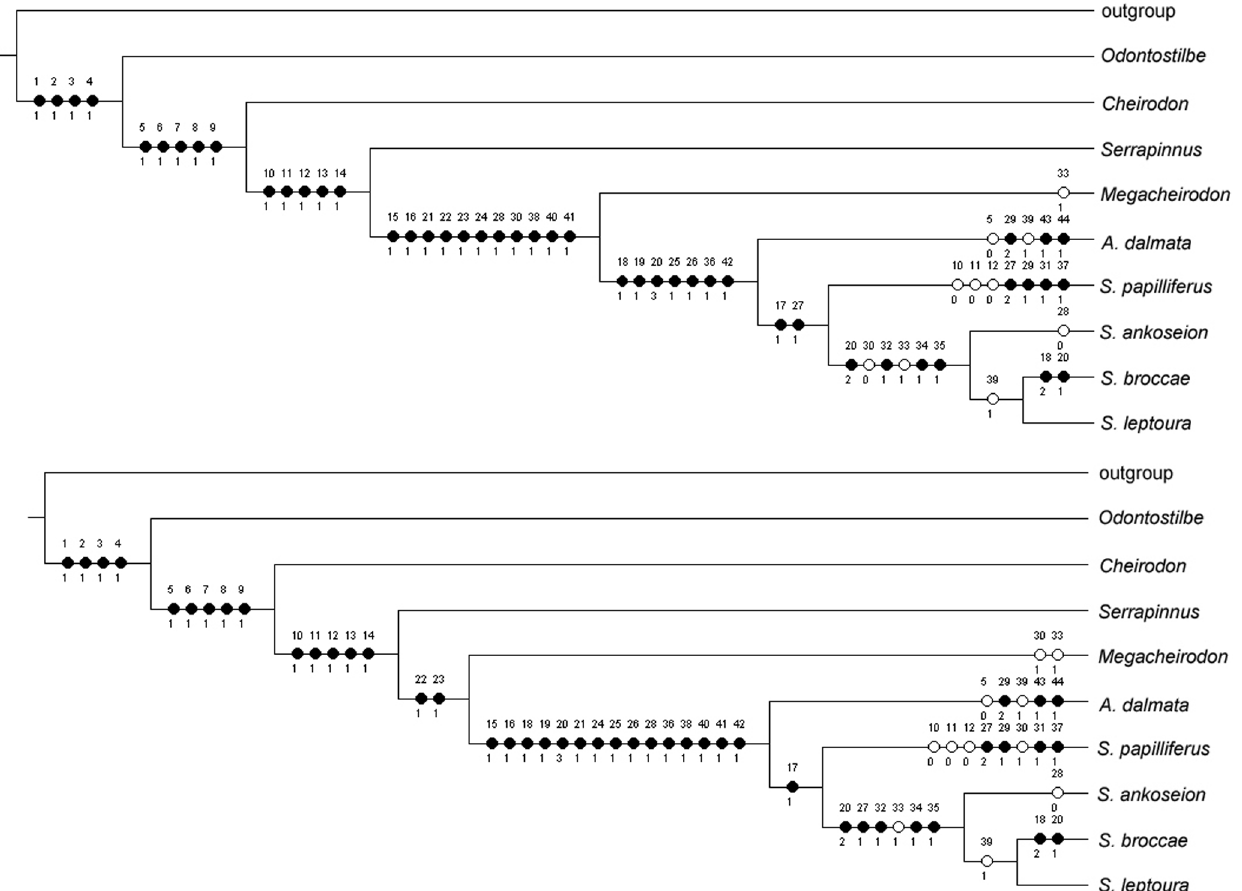
Fig. 13. Phylogeny of Amazonspinther dalmata and related cheirodontine taxa, including † Megacheirodon unicus (tree length = 55, Consistency Index = 0.85, Retention Index = 0.91). Characters 6, 7, 8, 9, 10, 11, 12, 13, 14, 22, 23, 28, 32 and 37 were coded as missing in the data matrix for A. dalmata , and characters 1, 2, 15, 16, 17, 21, 24, 28, 31, 34, 35, 38, 39, 40, 41 and 43 were coded as missing in the data matrix for † M. unicus . Ambiguous optimizations in both A. dalmata and † M. unicus are shown according to ACCTRAN (above) or DELTRAN (below)